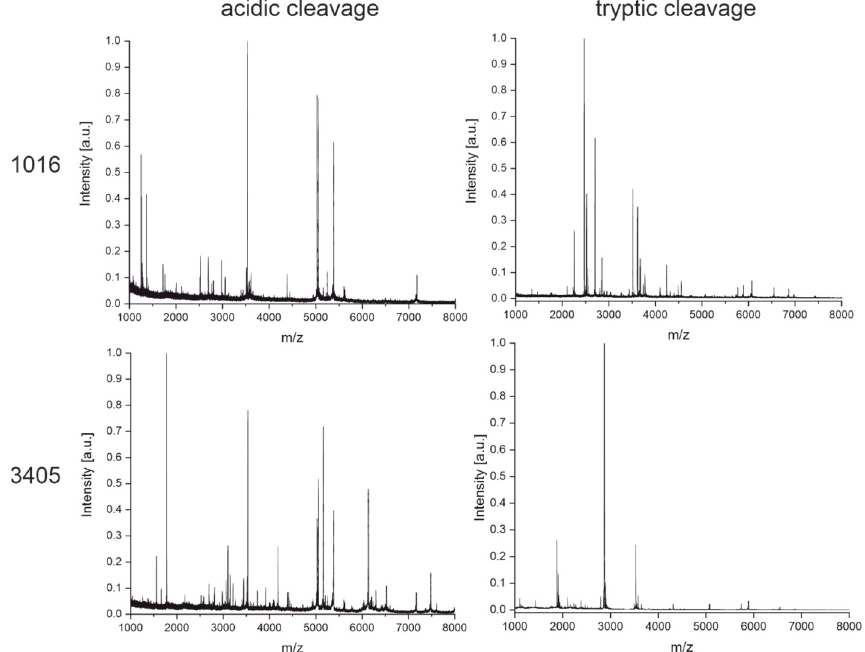
Figure 9. MALDI-TOF fingerprint spectra of the monoclonal antibodies 1016 and 3405 were obtained from cleavage with diluted sulfuric acid for 30 min at 99 °C and tryptic digestion for 15 min at 55 °C. Antibodies 1016 and 3405 originated from different immunizations but have similar light chain and intact masses. However, some obvious differences showed up in the fingerprints based on acidic cleavage and tryptic digest.